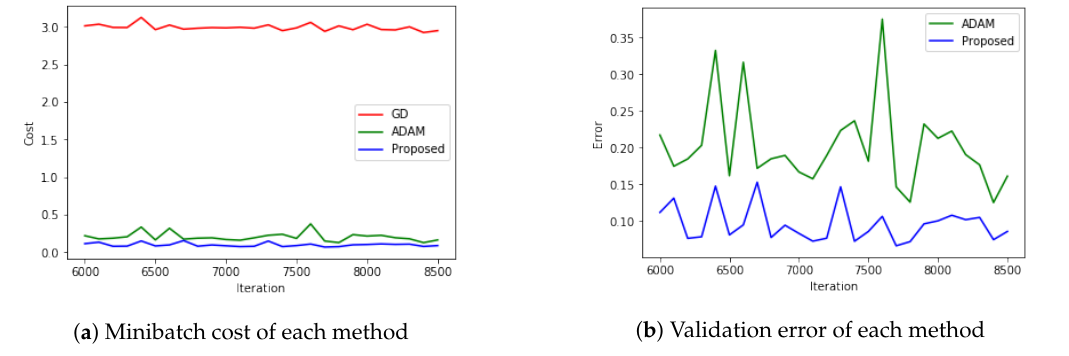
Figure 14. Comparing the proposed scheme with other schemes with an iteration number over 6000.